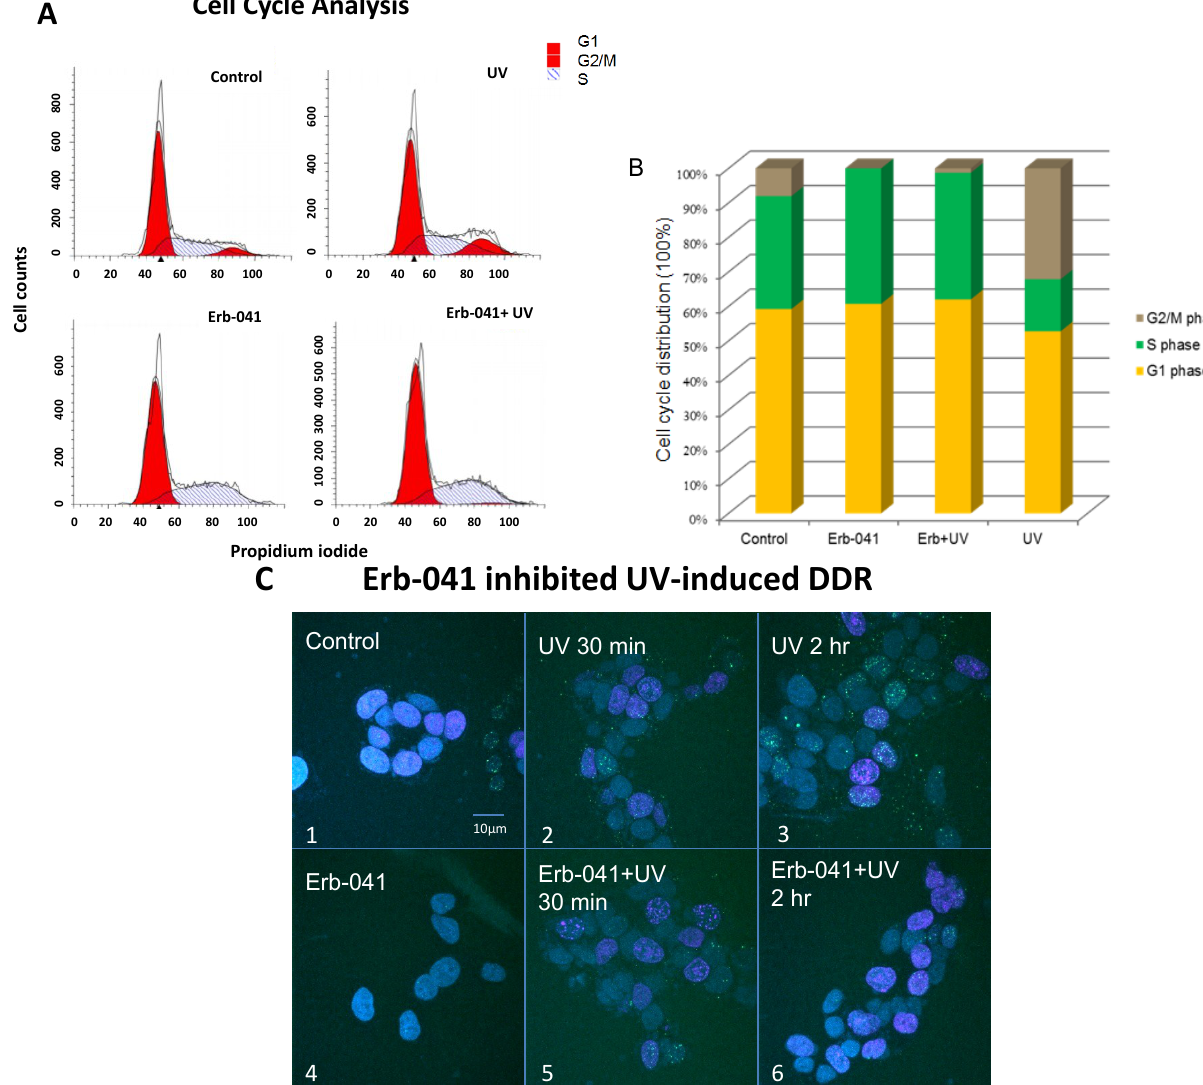
Figure 2. Erb-041 mediated cell cycle arrest in S phase and potentiated UV-induced DNA synthesis ( A ) MCF-7 cells were treated with Erb-041 for 24 h prior to UVC irradiation. After irradiation, exponentially growing cells were further incubated for 24 h prior to overnight ethanol fixation. The amount of DNA in each cell was measured by FACS after propidium iodide staining; ( B ) Quantitative analysis of the cell cycle distribution in the setting described in ( A ); ( C ) DNA synthesis and damage were assayed by immunofluorescence staining with the nucleotide analog, EdU, as well as anti-γH2AX antibody. After being treated with Erb-041 for 24 h, cells continued to undergo 30 min EdU incorporation, which was terminated by PBS wash and medium replacement. Cell irradiation was then carried out prior to fixation and subsequent incubation with anti-EdU reaction buffer, anti-γH2AX antibody, the designated fluorophore antibody and DAPI. EdU incorporation was represented by the purple fluorescence of Alexa Fluor 647 while γH2AX foci and the cell nuclei were indicated by the green fluorescence of Alexa Fluor 488 and DAPI, respectively. Description of experimental conditions: image #1, cells without any